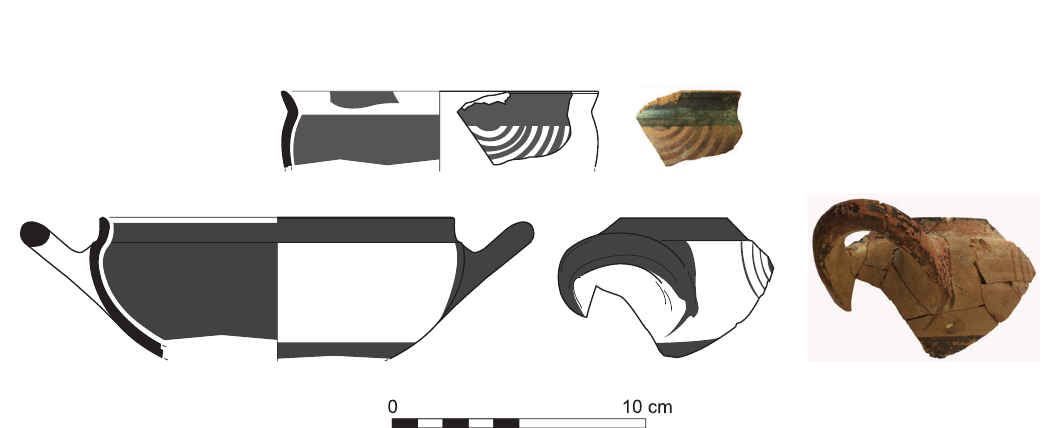
Fig 30. Fragments of Euboean (NAA) pendent semicircle skyphoi from Sidon phase I dating to Middle Geometric II / Subprotogeometric IIIB.